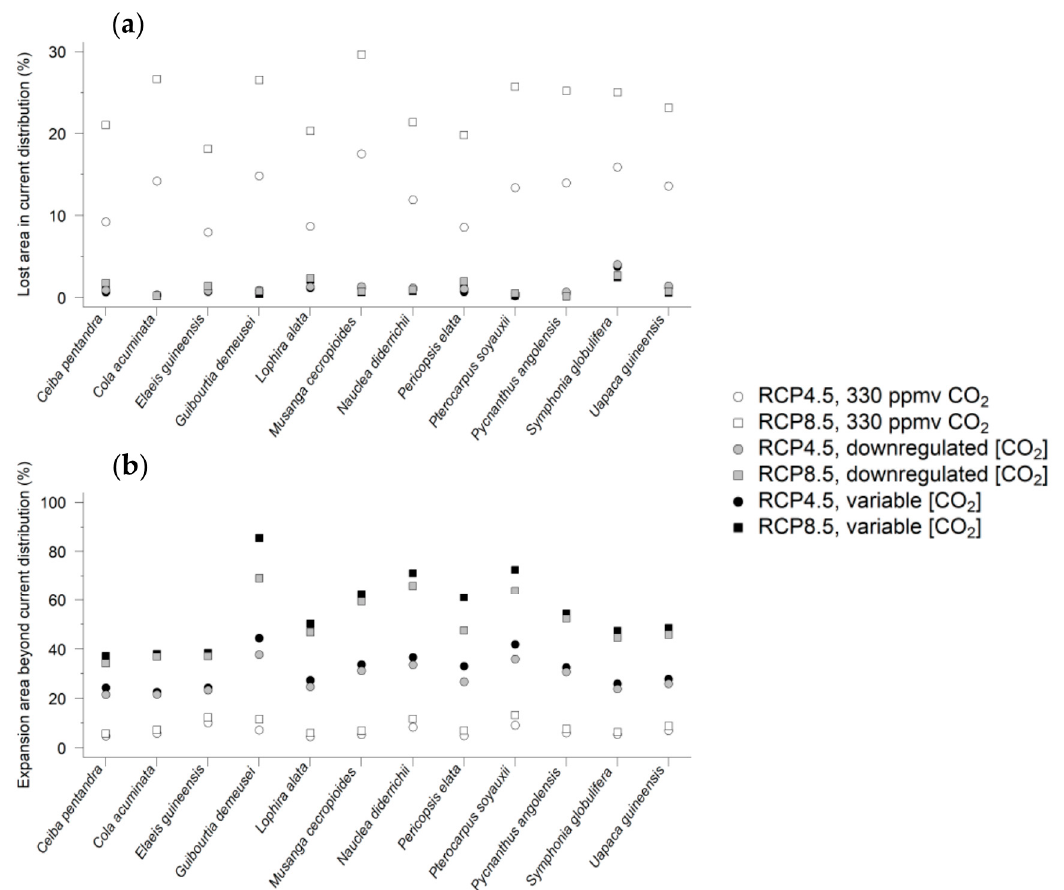
Figure 6. Changes in species distribution between the 2080–2099 period and the reference 1980–1999 period. ( a ) Lost area in the species current distribution and ( b ) expansion area beyond the current distribution, considering NPP values above the presence threshold of 100 g C m − 2 yr − 1 . The values correspond to the ensemble mean of the results obtained with the seven climate projections under the RCP4.5 (squares) and RCP8.5 (circles) scenarios, and three CO 2 configurations assuming respectively a CO 2 constant [330] (white), a CO 2 variable downregulated [down] (grey) and a CO 2 variable [var] (black), and species-specific morpho-physiological traits.